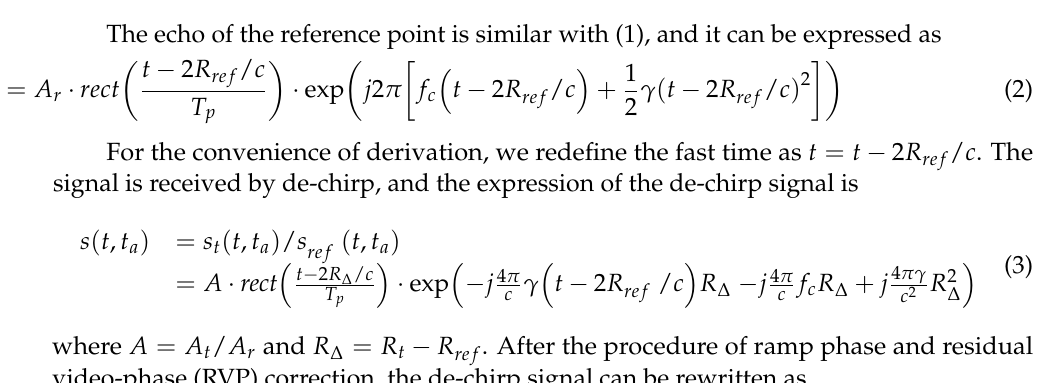
Figure 1. The imaging geometry.